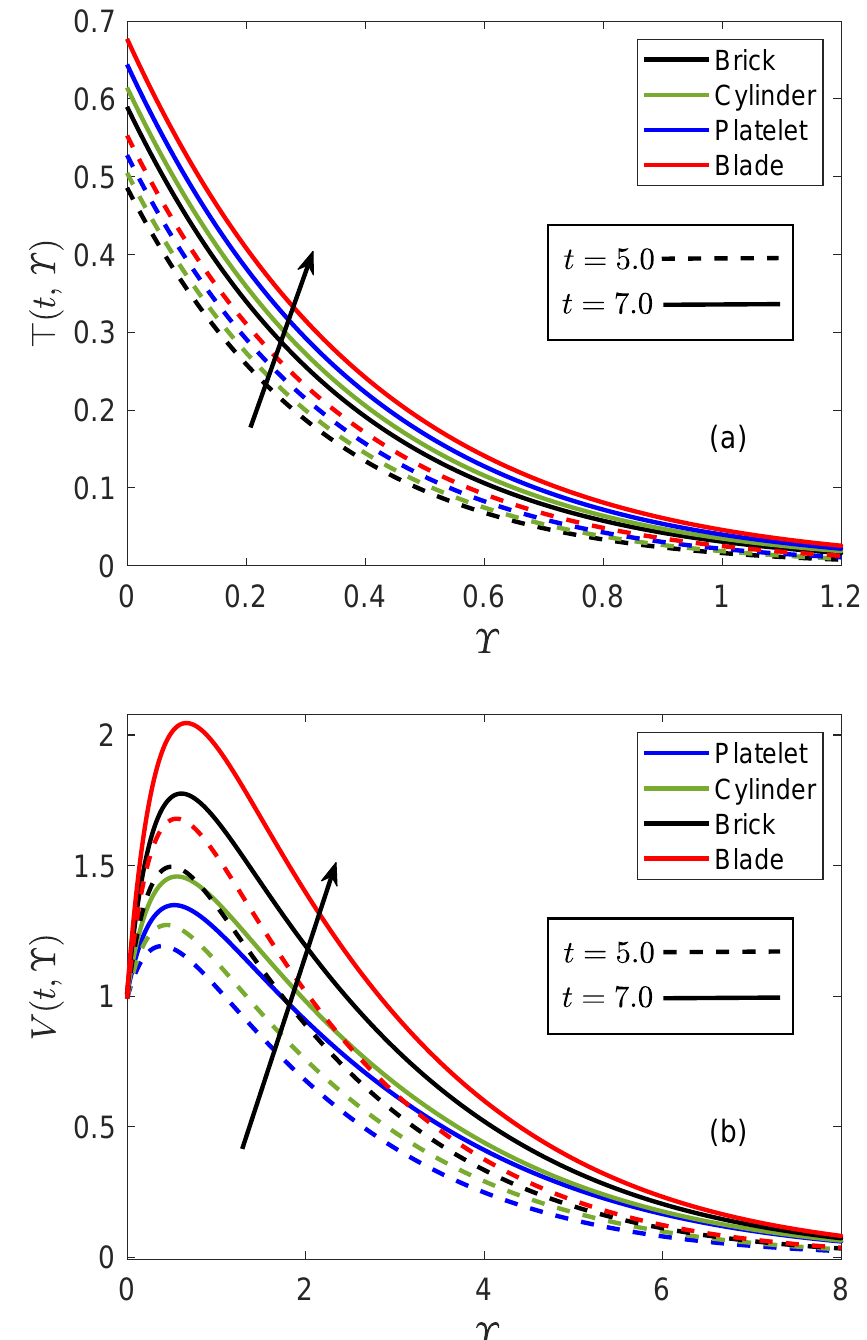
Figure 8. ( a ) Thermal patterns for different shapes of nanoparticles and larger time inputs. ( b ) Flow patterns for different shapes of nanoparticles and larger time